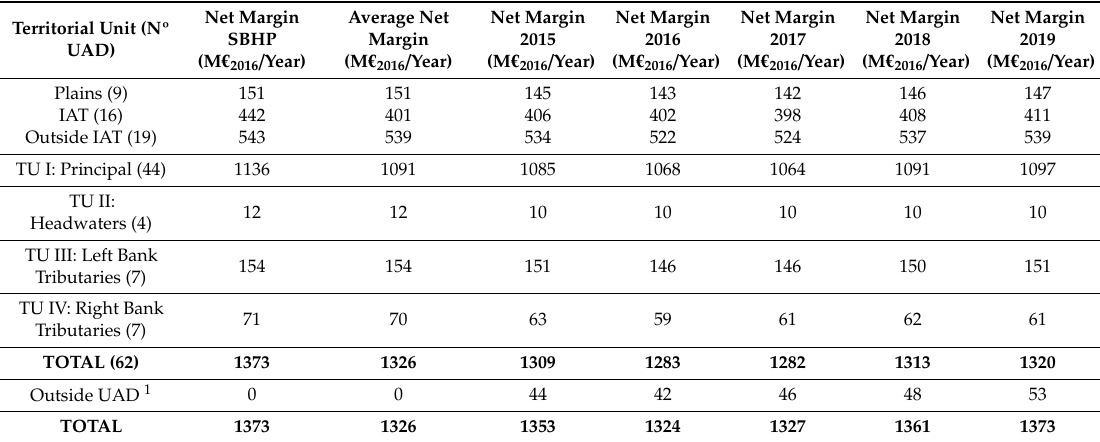
Table 10. Evolution of net margin 2015–2019 Source: HPO. Own